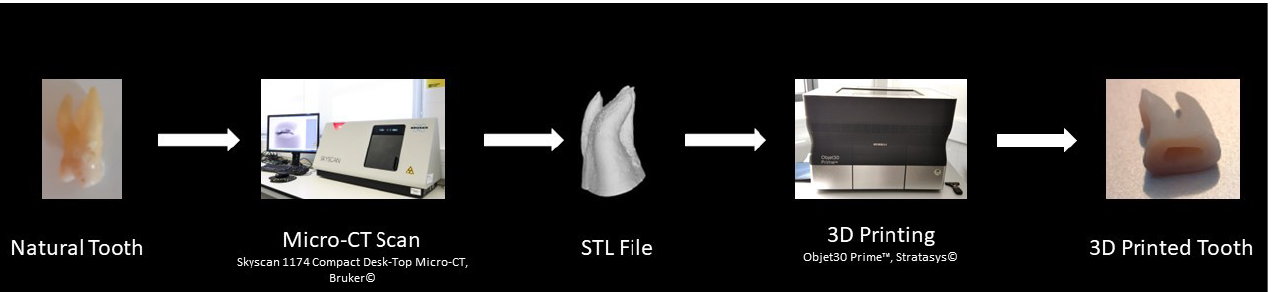
Figure 1. Three-dimensional printing process. (Micro-CT—Micro-Computer Tomography; STL— Standard Tessellation Language).